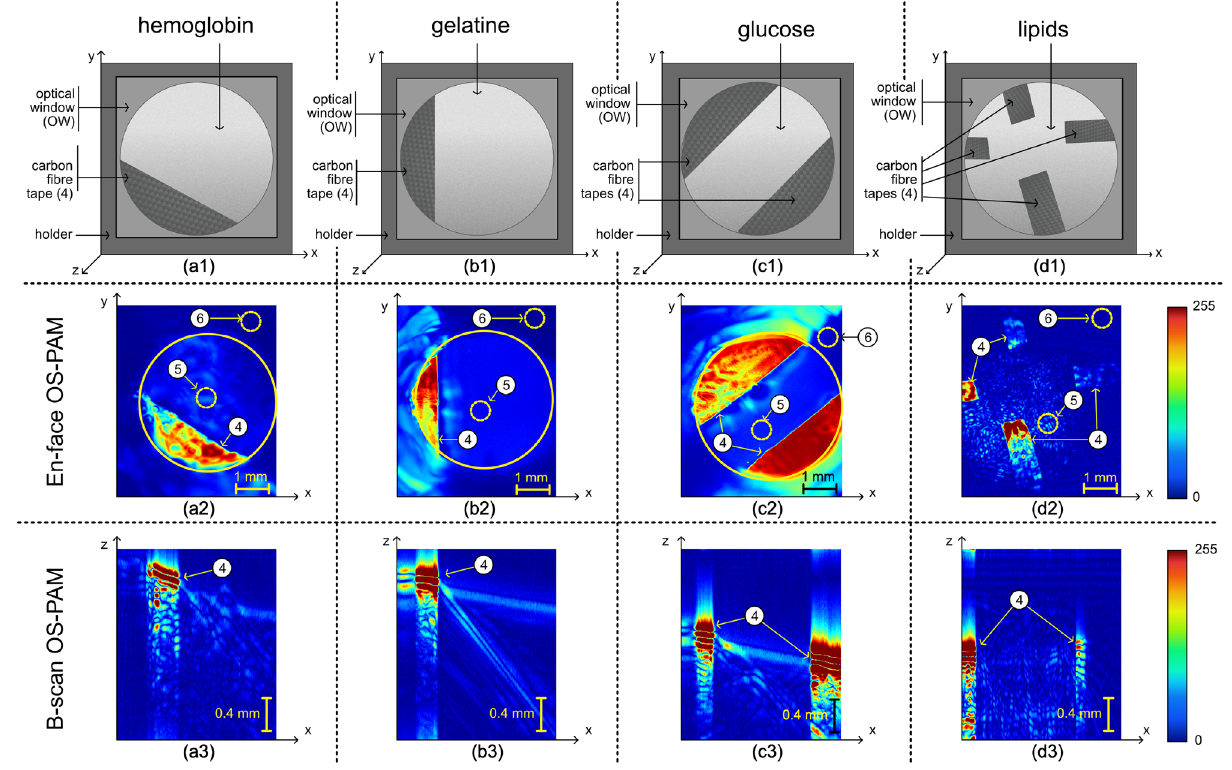
Figure 4. ( a1 ), ( b1 ), ( c1 ) and ( d1 ) Schematic diagrams of the samples designed to produce PAM spatial distribution maps of: hemoglobin, gelatine, glucose, and lipids respectively. In all cases, carbon fibre tapes (4) are placed on the optical window (OW) and covered by the liquid mixture created. ( a2 ), ( b2 ), ( c2 ) and ( d2 ) En face PAM maps showing the presence of hemoglobin, gelatine, glucose, and lipids respectively. Regions 5 and 6 are used to calculate the signal-to-noise ratio using the procedure described within the manuscript. ( a3 ), ( b3 ), ( c3 ) and ( d3 ) Examples of B-scan PAM images of hemoglobin, gelatine, glucose, and lipids respectively. All images show the carbon fibre tapes (4). Chromophore